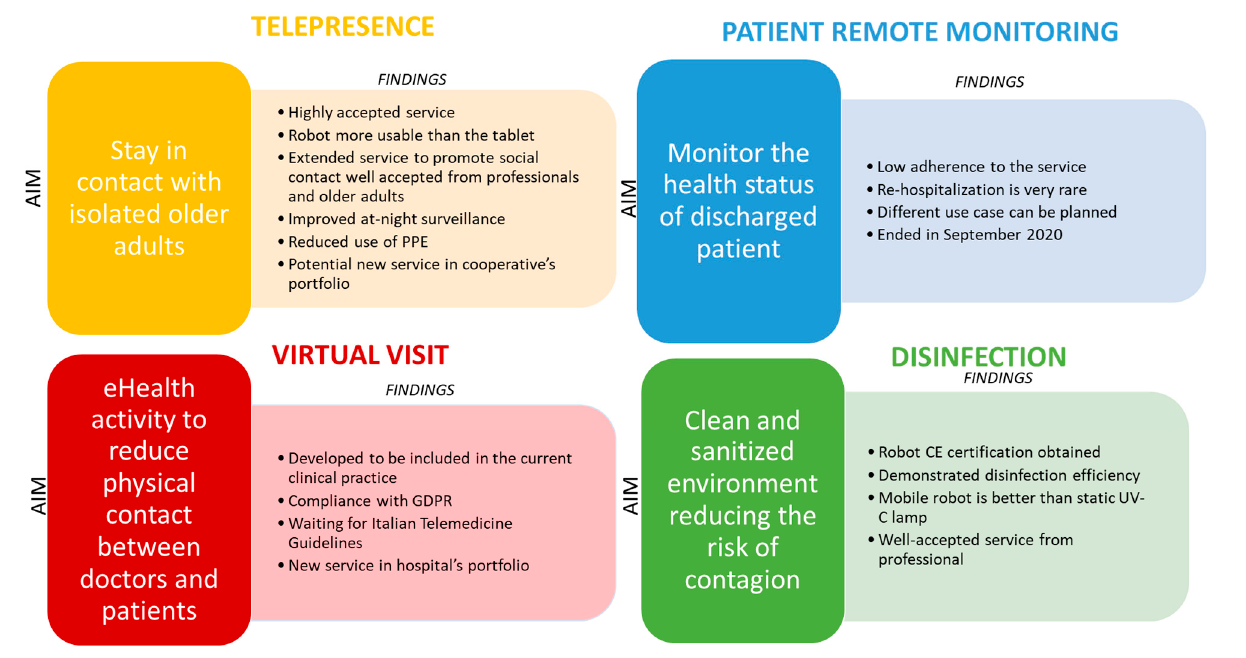
Figure 5. Lessons learned for each implemented service. For each service, the aims and findings are